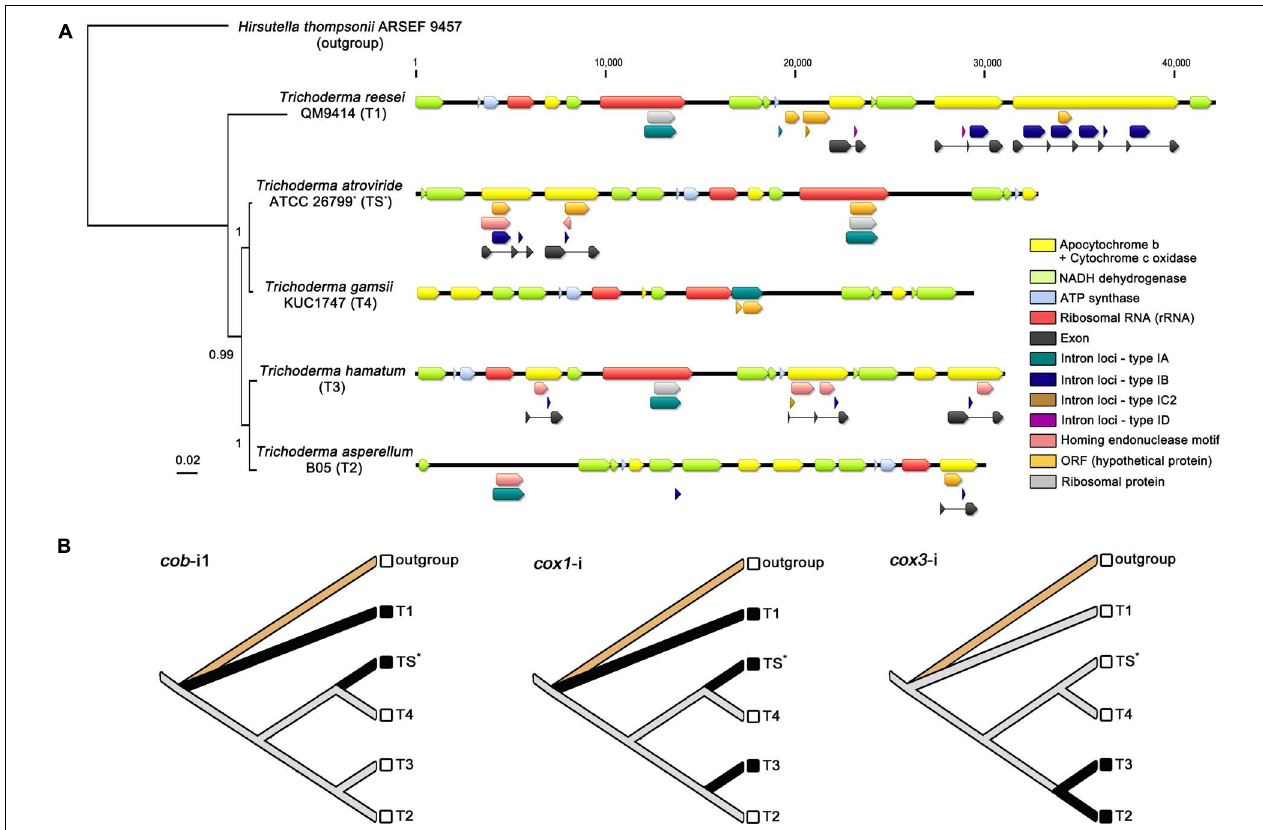
FIGURE 5 | Comparative analysis of Trichoderma mitochondrial introns. (A) All detected intron loci (described in Table 3 ) were displayed on the mitochondrial genomes with a BI based topology constructed using concatenated exon nucleotide sequences of 13 core genes ( atp6, atp8, cob, cox1 , cox2 , cox3 , nad1 , nad2 , nad3 , nad4 , nad4L , nad5 , and nad6 ). All gene components were indicated with different color blocks. (B) Inference of gain/loss events of Trichoderma mitochondrial introns. Reconstructed ancestral states for introns were presented with species names designated as, outgroup for Hirsutella thompsonii ARSEF 9457 (Ophiocordycipitaceae), TS for T. atroviride ATCC 26799 (with an asterisk), T1 for T. reesei QM9414, T2 for T. asperellum B05, T3 for T. hamatum , and T4 for T. gamsii KUC1747. Solid black lines indicate the presence of a given intron character in corresponding species.